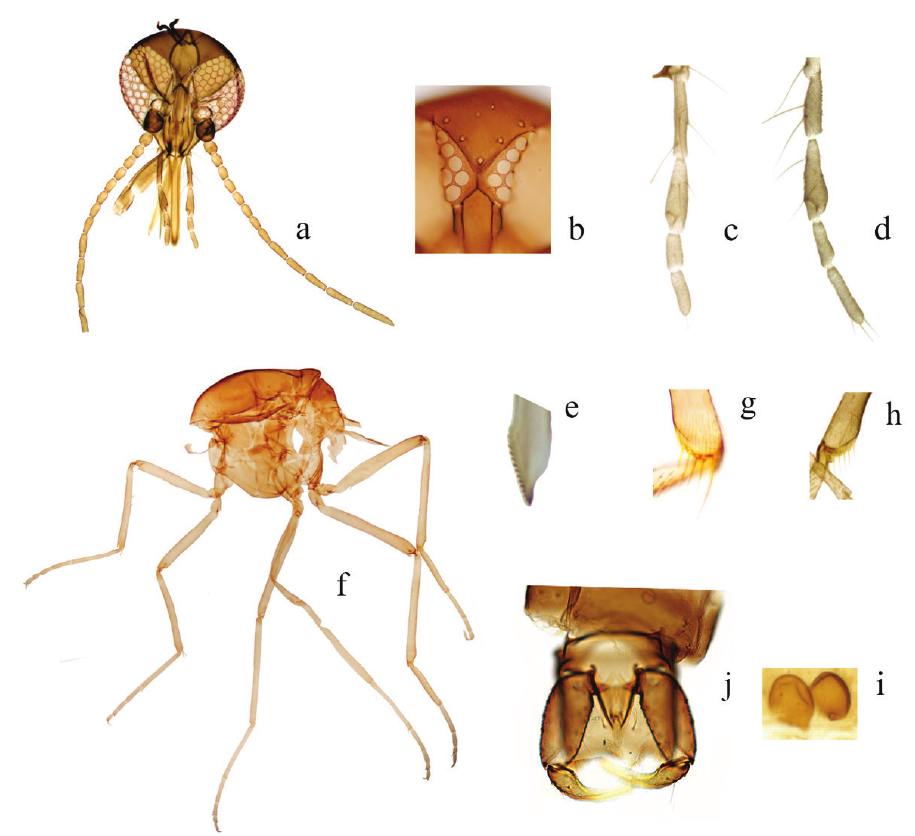
Figure 2. a–j Culicoides ( A. ) fenggangensis sp. n. a Head, anterior view b Eye contiguous, anterior view c Left palpus, anterior view d Right palpus, anterior view e Mandibular teeth f Thorax and legs, lateral view g Apex of hind tibia and base of first tarsomere, posterior view. h Apex of hind tibia and base of first tarsomere, posterior view. i Spermathecae j Genitalia, ventral view (Female: a–c, e–i ; Male: d, j ). necks with 2.5–7.5 (n = 3) μm; third slender, elongate rudimentary spermatheca, length 20.0–25.0 (n = 3) μm. Male . Similar to female with usual sexual differences. Sensilla coeloconica on flagel- lomeres 1, 11–13; AR 0.87 (n = 1); PR 3.11 (n = 1). Wing with pattern of pale spots as